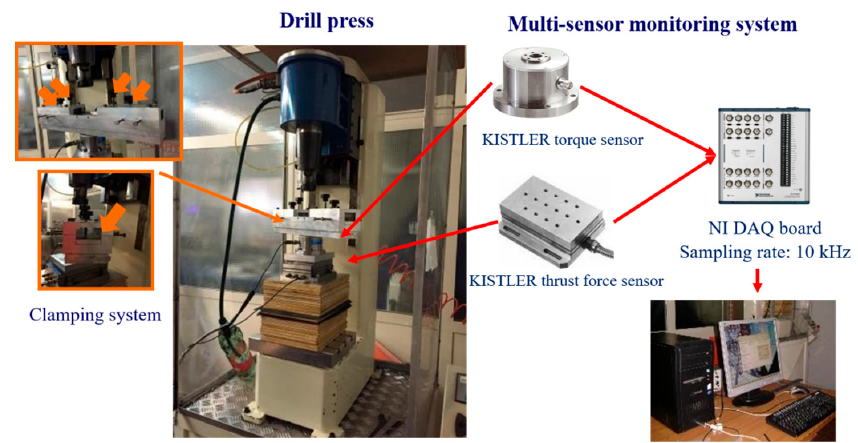
Figure 2. Experimental set-up of CFRP / CFRP stack drilling.